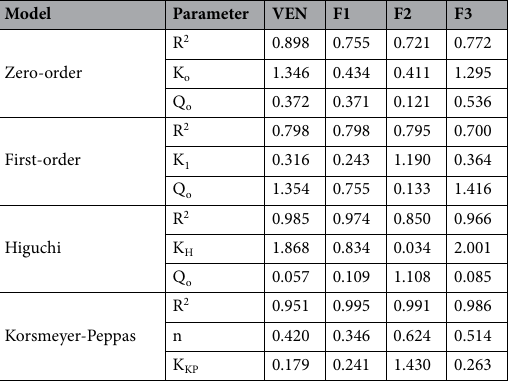
Table 2. Release kinetics of in vitro release data. Where; R 2 is correlation coefficient; while, Ko, K 1 , K H and K KP are zero-order release, first order release, Higuchi, and Korsmeyer constants, respectively. Qo and n are the initial release amount (µg/mL) and diffusion or release exponent, respectively.